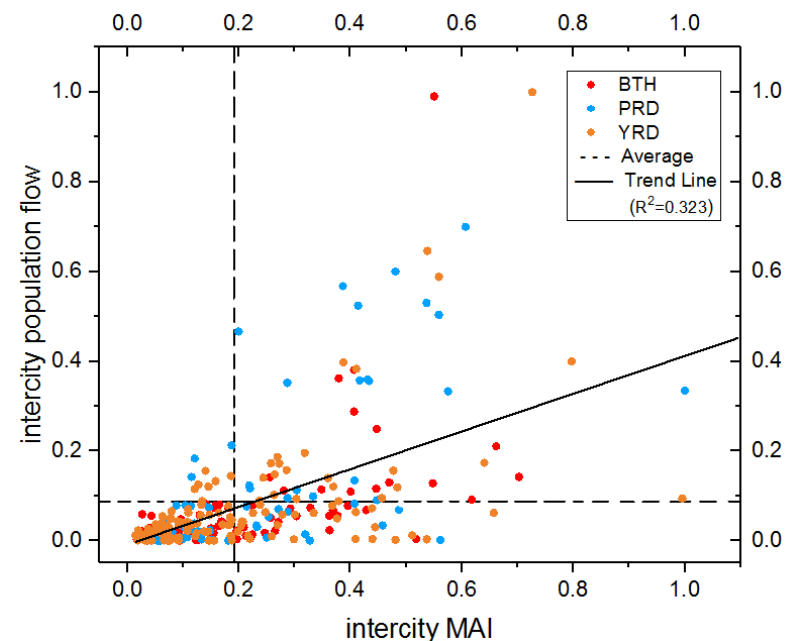
Figure 7. The scatter plot of intercity-MAI and intercity population flow.